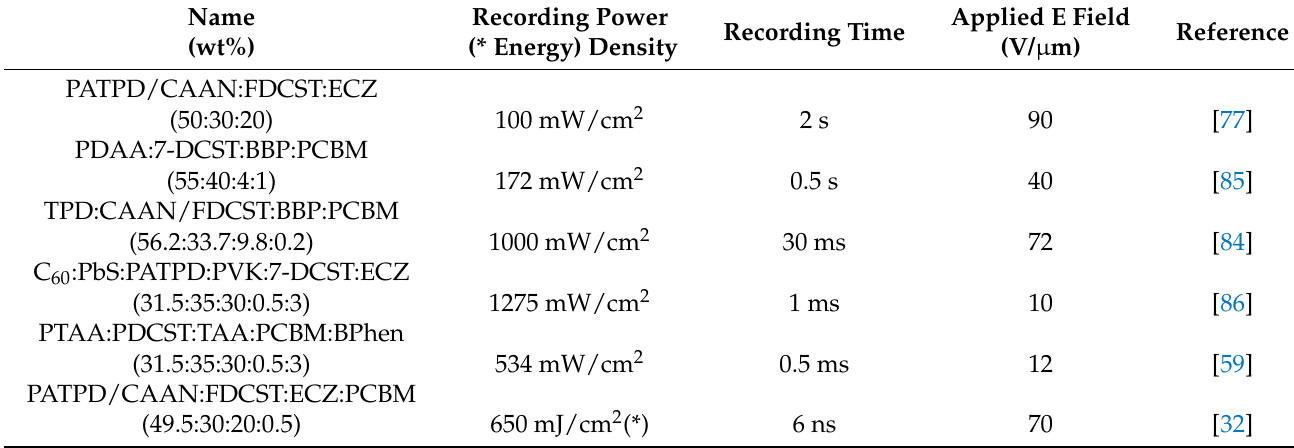
Table 1. Recording metrics for some of the photorefractive polymers used for holographic display application. Name Recording Power